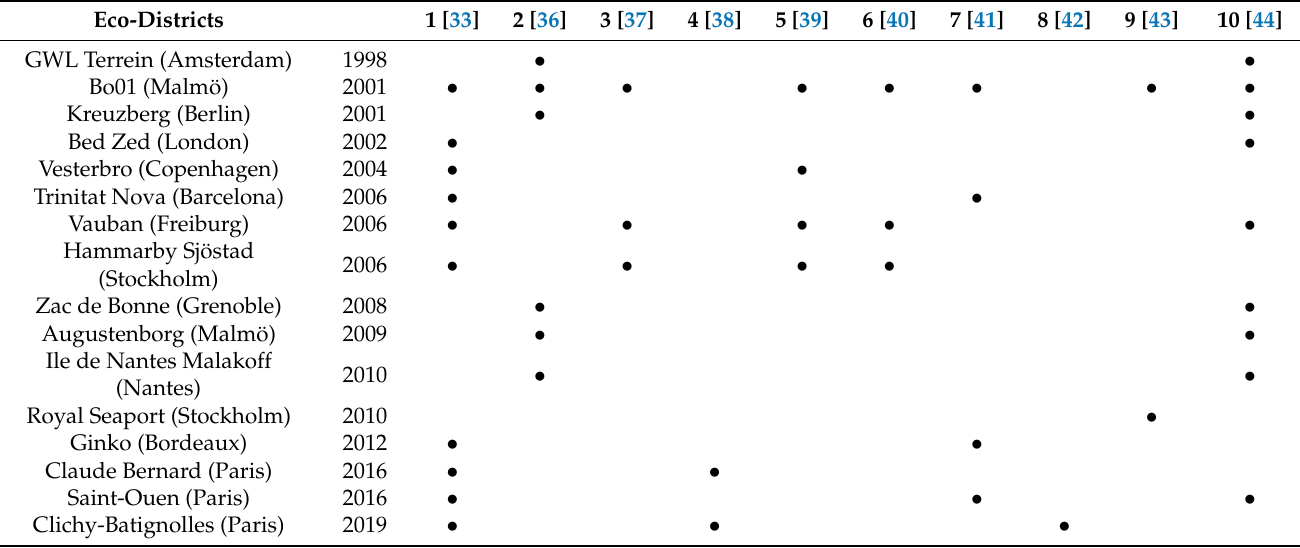
Table 2. Literature review on eco-districts and emblematic case studies illustrated in the cited publications. Source: Authors’ elaboration (2022) from scientific literature